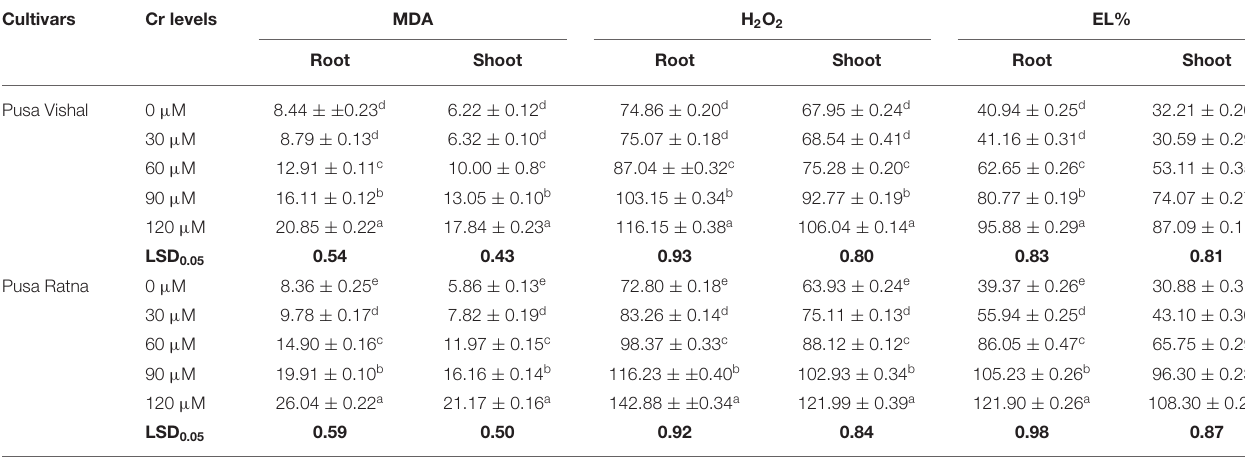
TABLE 1 | Effect of different treatment levels of Cr (VI) on malondialdehyde (MDA, µ mol · g − 1 fresh weight) and hydrogen peroxide (H 2 O 2 , µ mol · g − 1 fresh weight) contents and electrolytic leakage (EL %) in the roots and shoots of two Mungbean cultivars, Pusa Vishal (PV) and Pusa Ratna (PR). Cultivars Cr levels MDA H 2 O 2 EL% Root Shoot Root Shoot Root Shoot Pusa